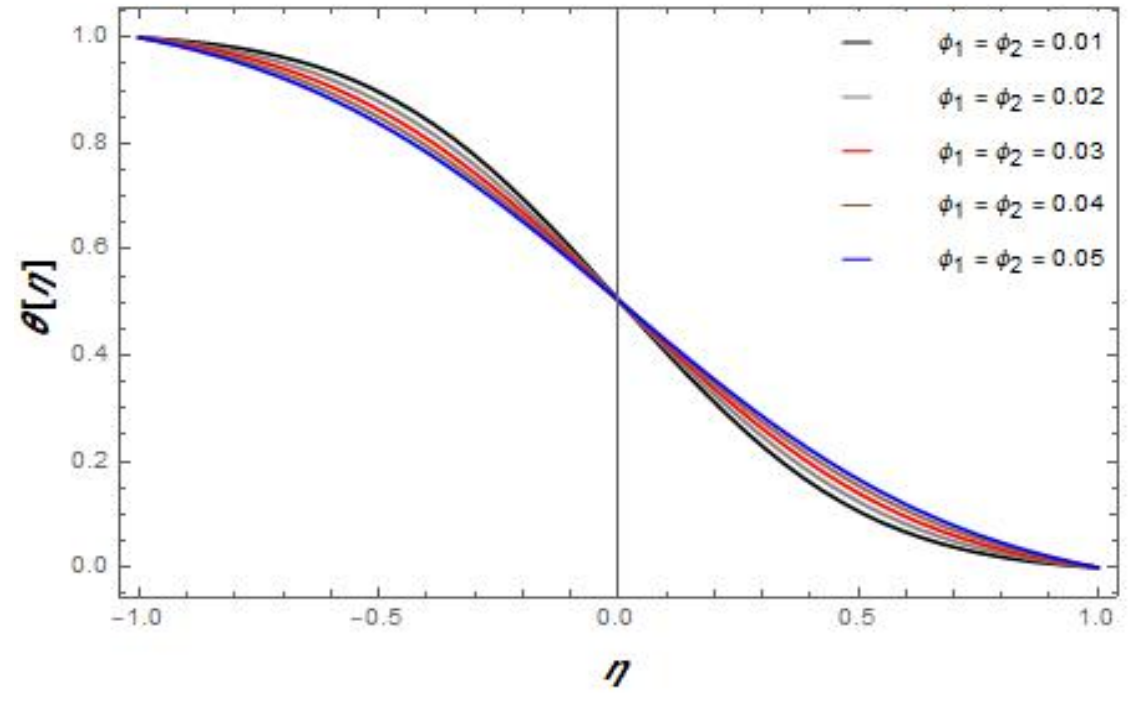
Figure 5. Effect of volume fraction on temperature.